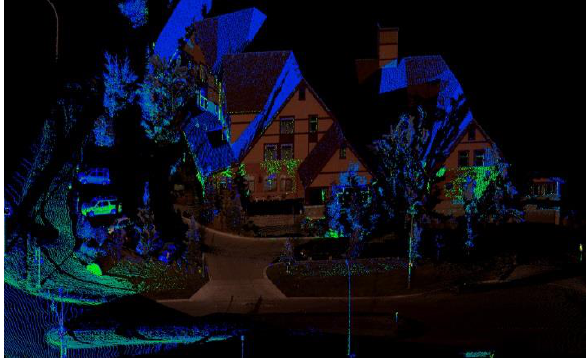
Figure 3. Result of registration the two scans. Figure (4) shows part of the scan scene to show the large area that can be covered with two scan using long range ToF laser scanner.